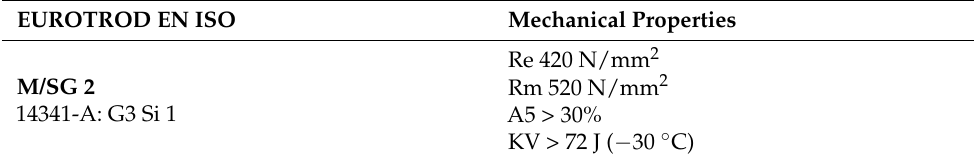
Table 3. Mechanical properties of the AWS 5.18 ER 70S-6 electrode.